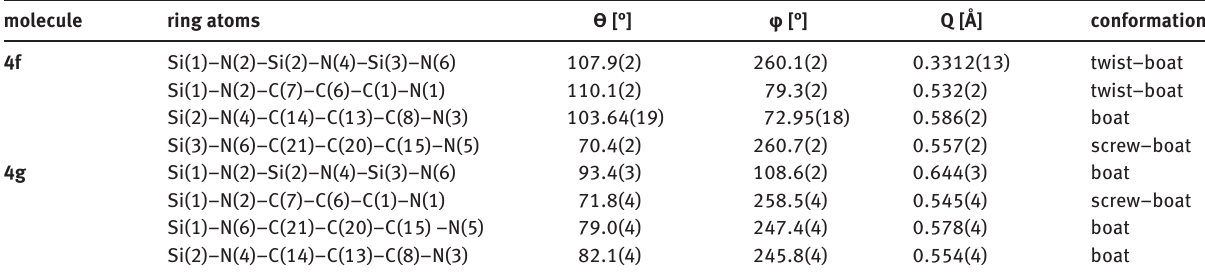
Table 9: Ring puckering analysis of structures 4f and 4g molecule ring